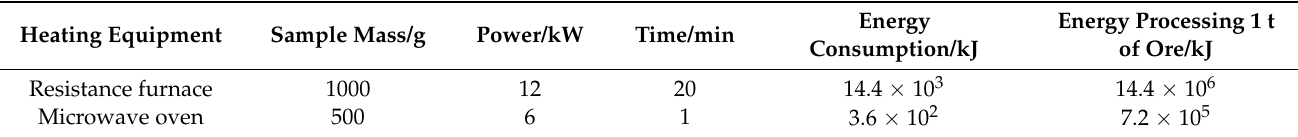
Table 11. Comparison of the electric energy consumption of the two heating